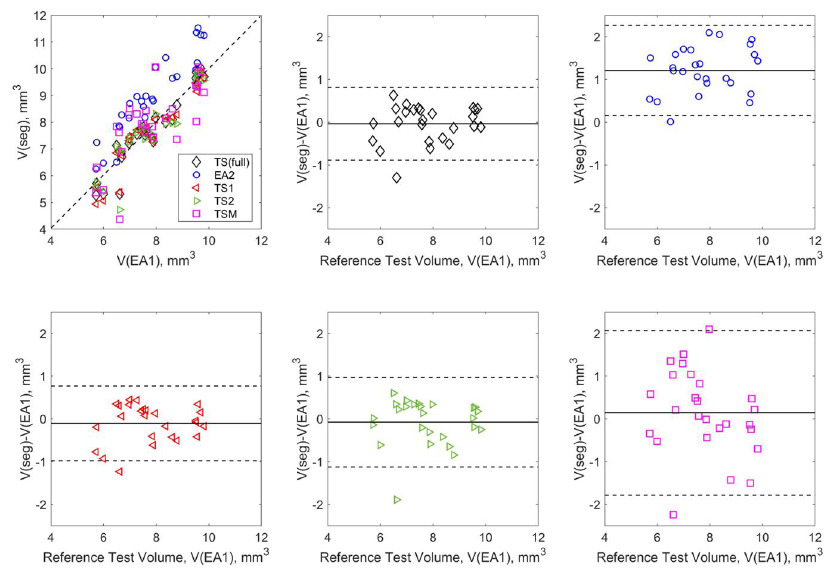
Figure 5. Tibia volume (including test – retest) accuracy for the test subset with respect to EA1 reference for different training scenarios (color-coded in the legend). Solid horizontal lines mark the bias (average volume difference), and dashed lines correspond to 95% limits of agreement.